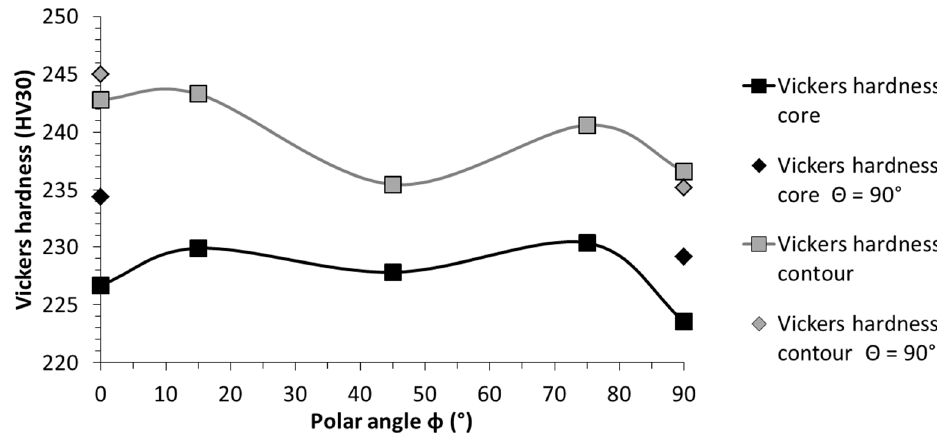
Figure 4. Orientation dependency of the surface hardness in both the as-build and machined condition. Table 4. Surface hardness results per configuration obtained on the machined samples. Config.